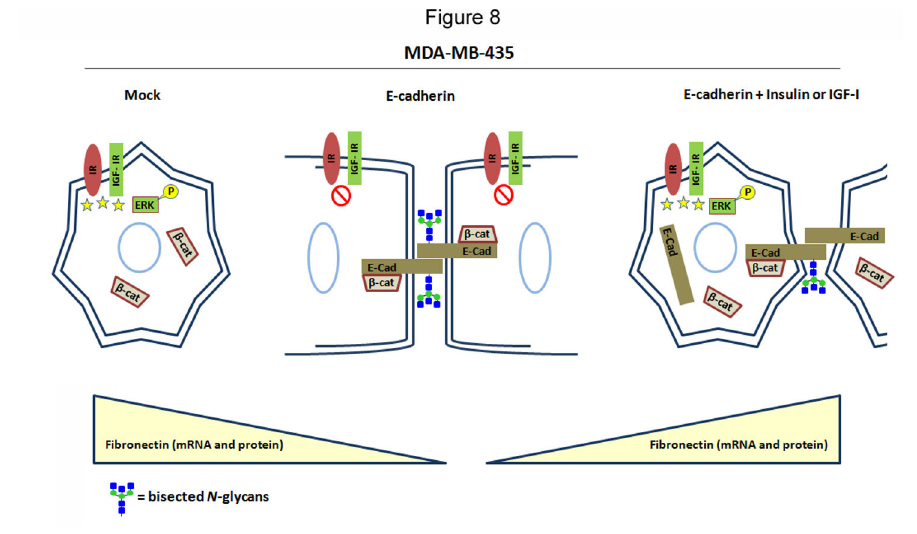
Figure 8. Proposing model for the interplay between E-cadherin, IR/IGF-IR, and bisecting GlcNAc N -glycans on the stabilization of both cell-cell adhesion and epithelial-like phenotype. The figure summarizes our findings and shows that exogenous E-cadherin expression leads to an inhibition of IR/IGF-IR signaling, concomitantly with increased levels of bisecting GlcNAc N -glycans expression which were previously shown to stabilizes adherens-junctions, ensuring an epithelial-like phenotype [18,35]. Stimulation with insulin or IGF-I activates IR/IGF-IR signaling and downstream protein ERK 1/2, promoting a decreased expression of bisecting GlcNAc structures in general and specifically on E-cadherin which was previously shown to destabilize cell- cell adhesion [18], leading to an invasive phenotype. Concomitantly, it was observed an increased expression of the mesenchymal marker fibronectin and cytoplasmic β-catenin and E-cadherin.